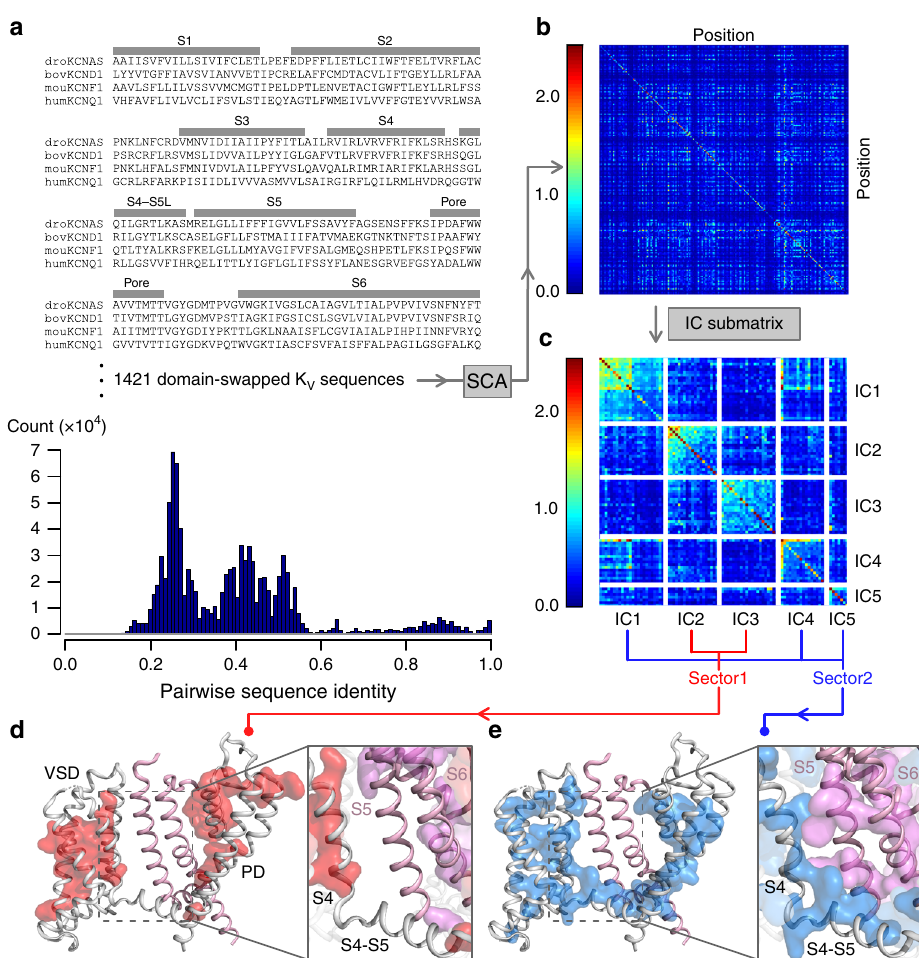
Fig. 6 Statistical coupling analysis suggest conservation of the two-stage E – M coupling across domain-swapped K V superfamily. a Sample multiple sequence alignment (MSA) containing domain-swapped K V channels (K V 1-K V 9) used as input for statistical coupling analysis (SCA). The bottom histogram shows counts for pairwise sequence identity between all pairs of residues within the MSA. MSA uses the nomenclature established by the HUGO Gene Nomenclature Committee (HGNC) for voltage-gated potassium channels 80 . b SCA covariance matrix calculated by SCA (see Methods). X and Y axes indicate amino acid positions, while colors indicate the degree of covariance, with blue and red corresponding to lowest and highest degrees of covariation. c The independent component (IC) submatrix visualizes a subset of the SCA matrix (panel b) in which the residues are the highest covariant. Each IC represents a group of co-varying/co-evolving amino acids as calculated by SCA (see Methods). Axes are amino acid position numbers. Diagonal boxes indicate covariation within each IC, off-diagonal boxes indicate cross talk between ICs. Sector 1 and sector 2 were de fi ned by combining the IC as shown (also see Methods and Supplementary Fig. 7). d – e Mapping sectors 1 and 2, as calculated by SCA, on the K V 7.1 cryoEM structure. The main subunit is colored gray, the neighboring subunit is colored pink. Sectors 1 ( d ) and 2 ( e ) on the main subunit are colored red and blue. Insets show S4, S4-S5L of the main subunit and S5, S6 of the neighboring subunit. The respective sectors on the neighboring subunit are colored magenta in the inset. All other elements in the insets are transparent for the clarity. Source data for SCA are provided as a Source Data fi